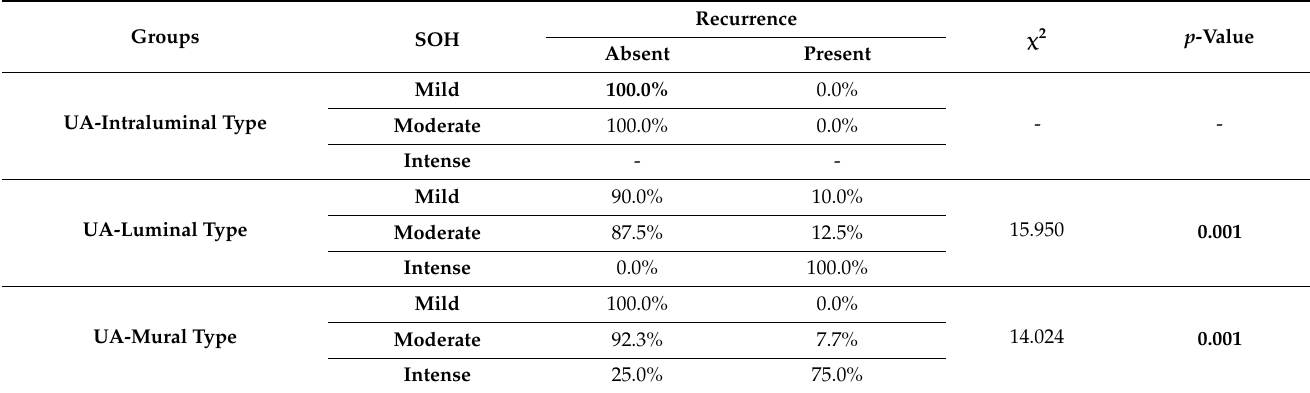
Table 2. Comparison of correlation of SOH with recurrence of unicystic